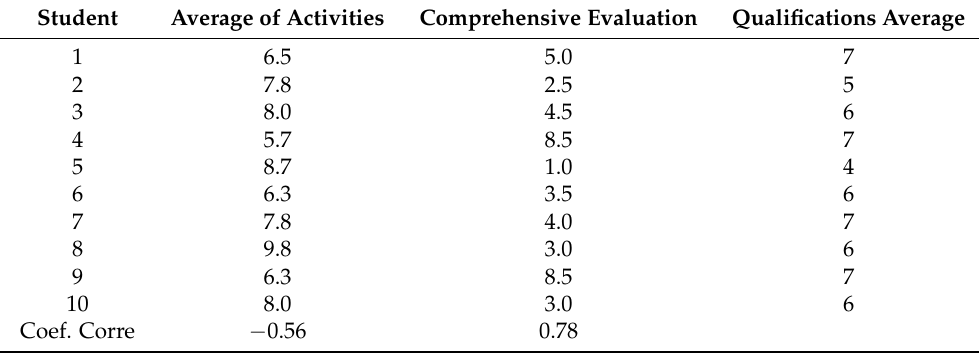
Table 3. Results of data processing, classification of activities versus score of comprehensive evalua- tion period